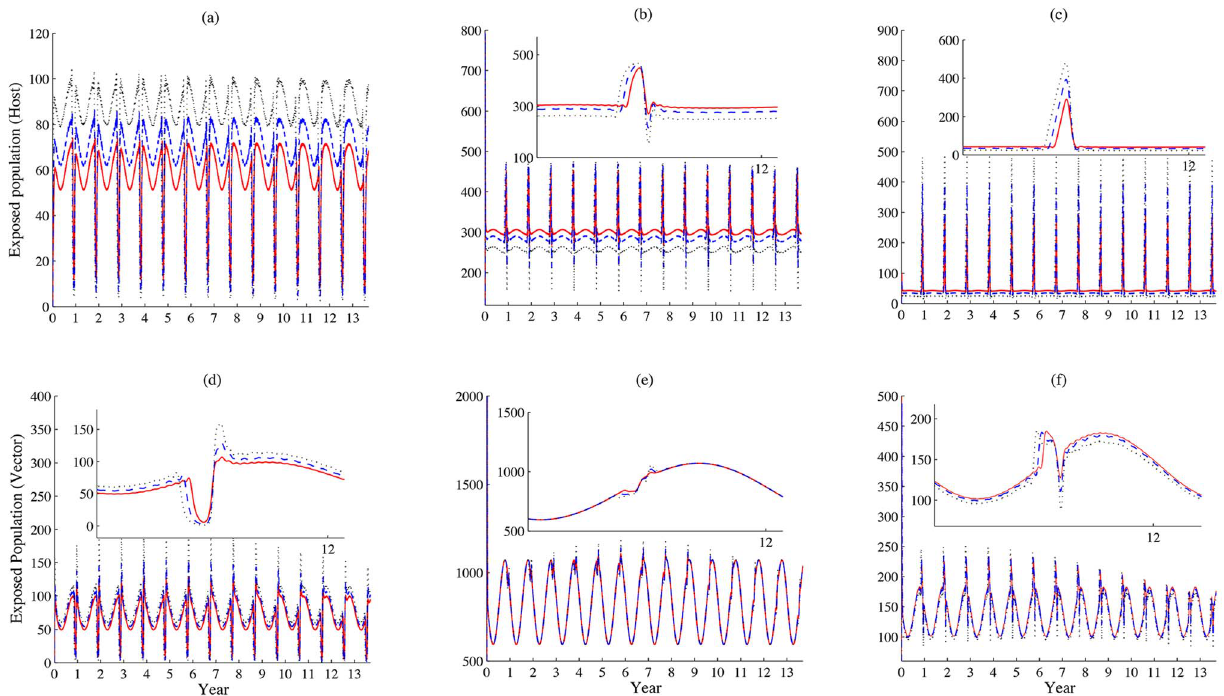
Fig. 12. How the starting time of festival preparation impacts patterns of disease outbreaks: exposed classes. (a)-(c) and (d)-(f), simulations of the populations of exposed livestock and vectors in patches 1–3, respectively. The starting time of festival preparation varies from 2, 4, to 6 weeks ago (n= 14,21,28 days), represented by solid, dashed and dotted lines, respectively. Values of other parameters are identical with those used in Fig. 3 and dc ~ 54 km = day , d (cid:2) mm ~ 0 : 02, dr ~ 40 . Unit: daily. When the preparation starts early, we are expecting a larger scale of disease outbreaks due to the higher concentration of livestock. Therefore, more individuals in exposed period we can observe when the starting time varies from 2 to 6 weeks ago.